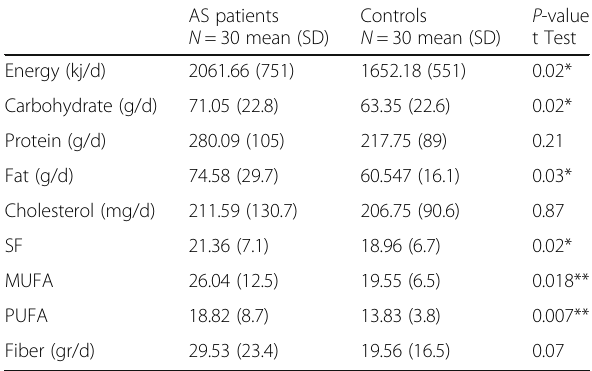
Table 2 Dietary intake of food components in AS and healthy groups Cases